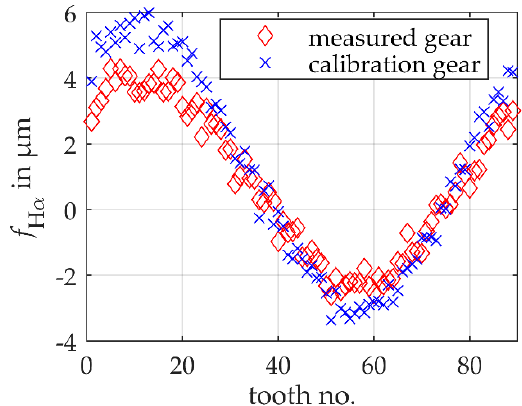
Figure 7. Profile slope deviations f H α of the individual teeth of two simulated non-modified involute spur gears.